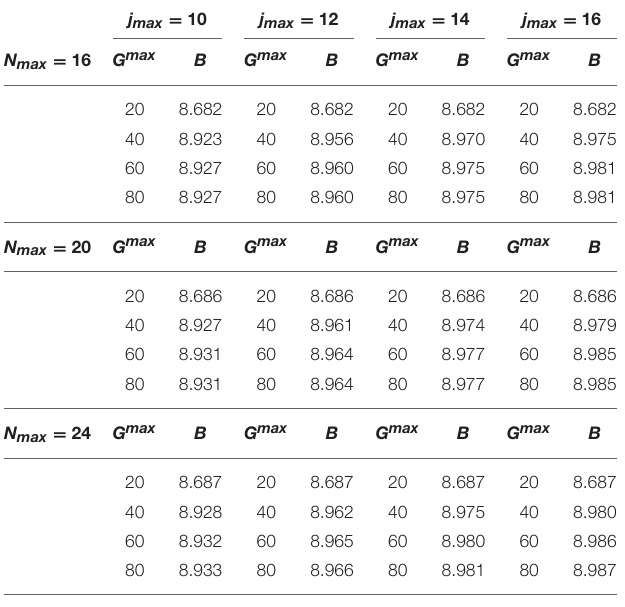
TABLE 7 | The 3 H binding energy B (in MeV) calculated with the AV4 ′ potential m p and γ model [ 16], using m n 4 fm − 1 . = =